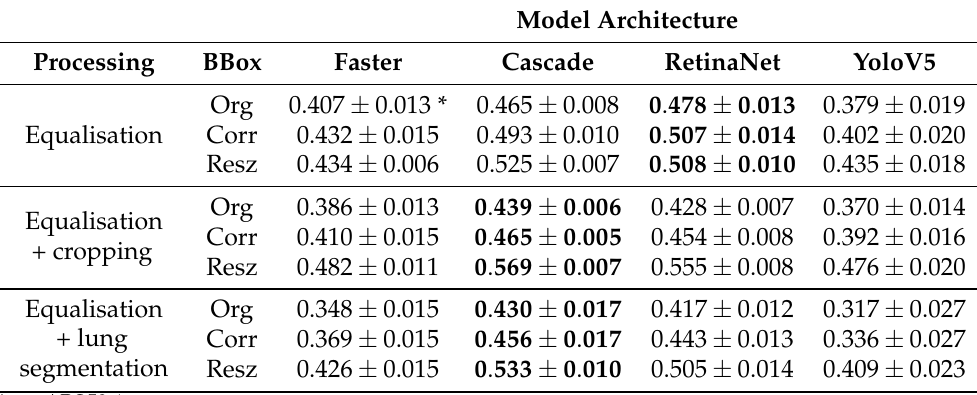
Table 2. Performance of the different model architectures for different image pre-processing strategies and evaluation procedures. The BBox column indicates the evaluation procedure for the bounding boxes used during validation: Originals (Org), Corrected (Corr), Resized (Resz).